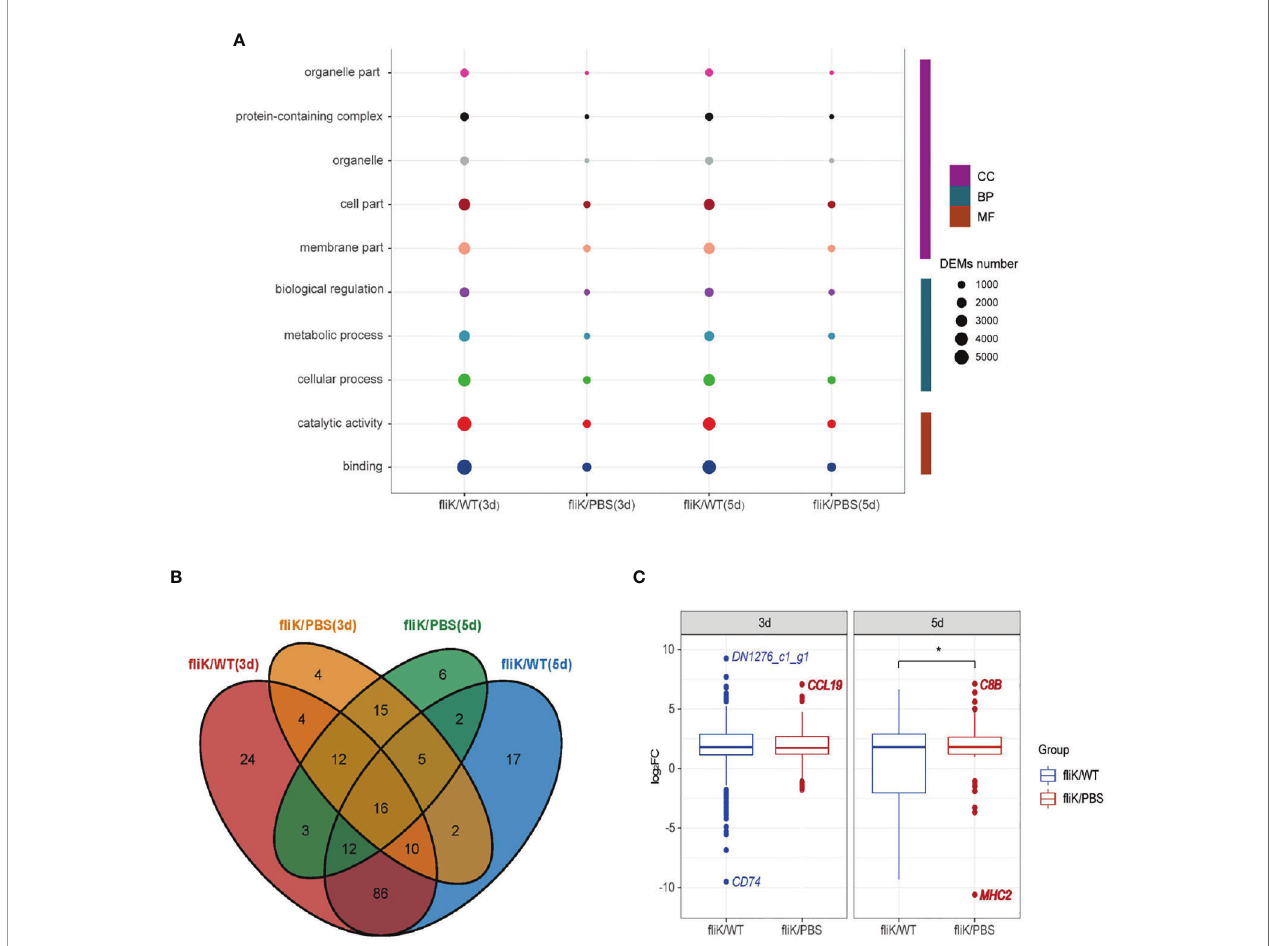
FIGURE 5 | GO annotation of comparative transcriptome data of fl iK -RNAi and WT strain infection groups (3 and 5 dpi). (A) Top 10 GO terms with number of annotated DEGs. (B) Number of DEGs annotated to “ Immune System Process ” in different comparison groups. (C) Distribution of expression level of DEGs annotated to “ Immune System Process ” (upper, middle, and lower horizontal lines in box represent upper quartile, median, and lower quartile, respectively. Upper- and lower-line segments represent maximum and minimum values of data, respectively; points outside boxes represent outliers. Blue indicates most up-regulated mRNA in fl iK -RNAi and WT strain infection groups, red indicates most up-regulated mRNA in fl iK -RNAi strain infection and PBS injection groups). *P <